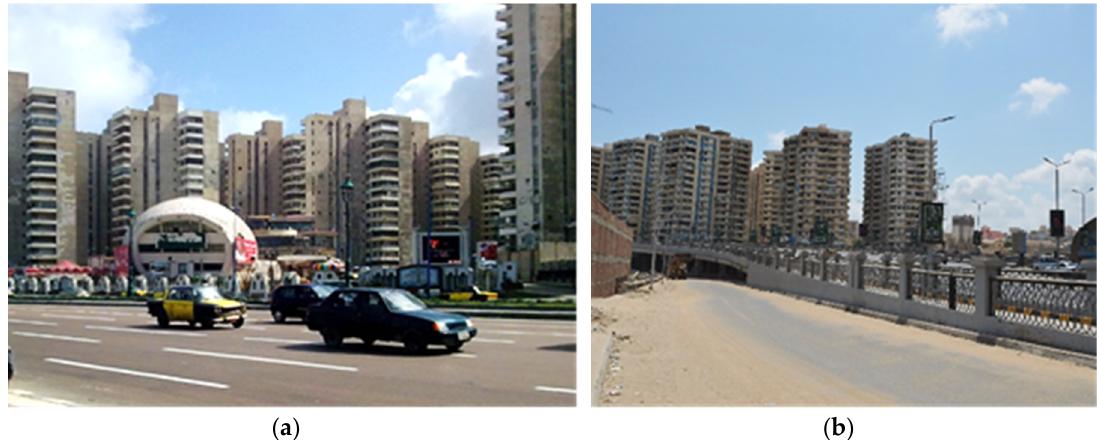
Figure 5. ( a ) The photo showing the Al Salam Theatre and its context before demolition. Source: [57]. ( b ) A recent photo from the same angle of view after removing the theatre, adding the traffic bridge, and changing the whole context. Source: F. Hussein.